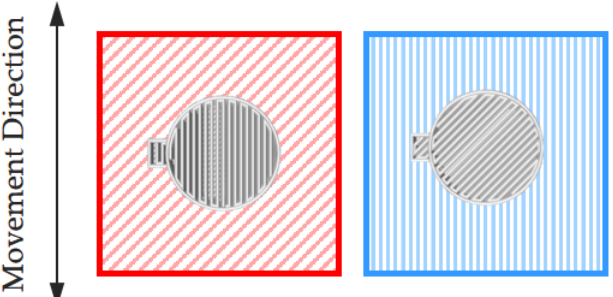
Figure 6. Illustration of two tribo-contacts with di ff erent arrangements of the grinding and infill orientation in relation to the direction of movement of the pin-on-plate experiment.